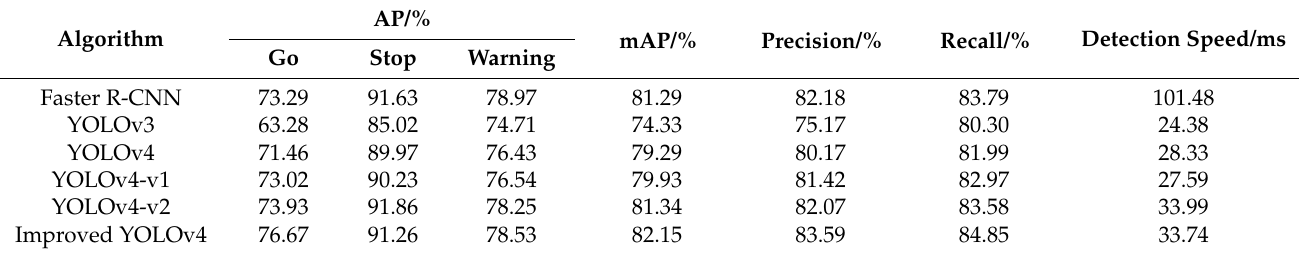
Table 8. Traffic light recognition performance index in the LISA data set.